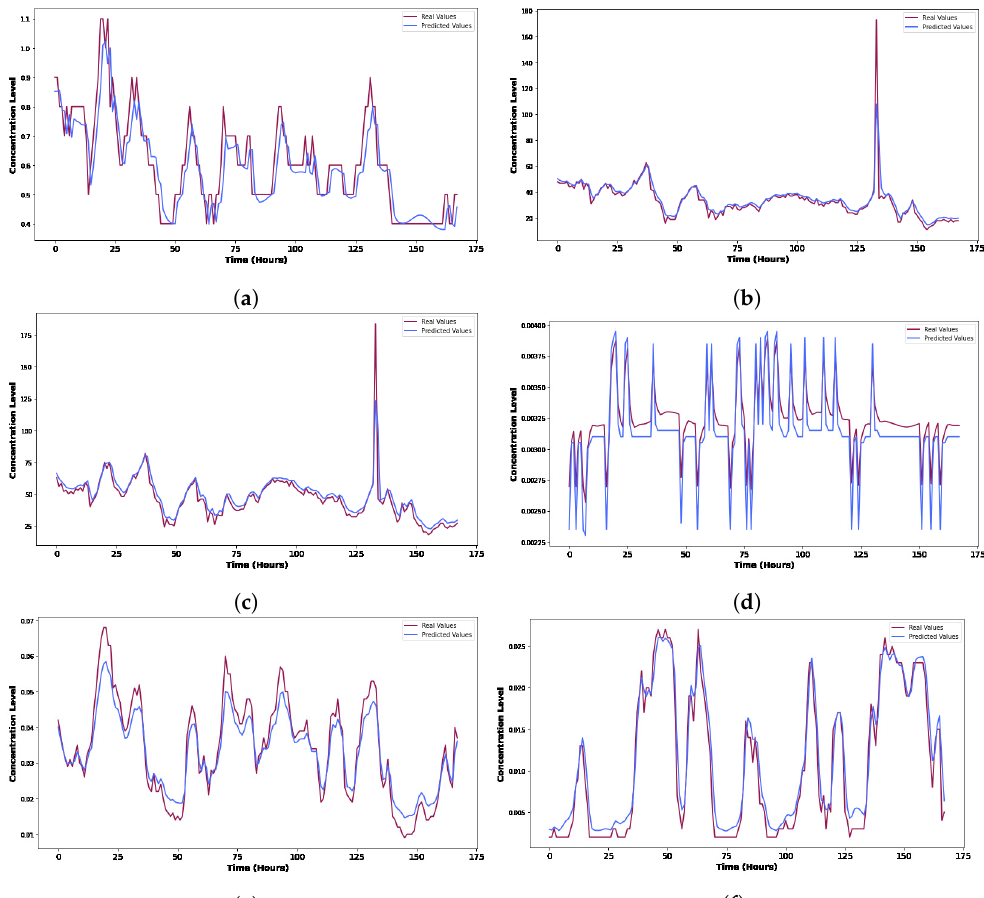
Figure 6. Comparison result of Real and Predicted air pollutant concentration of ( a ) CO , ( b ) PM 2.5 , ( c ) PM 10 , ( d ) SO 2 , ( e ) NO 2 and ( f ) O 3